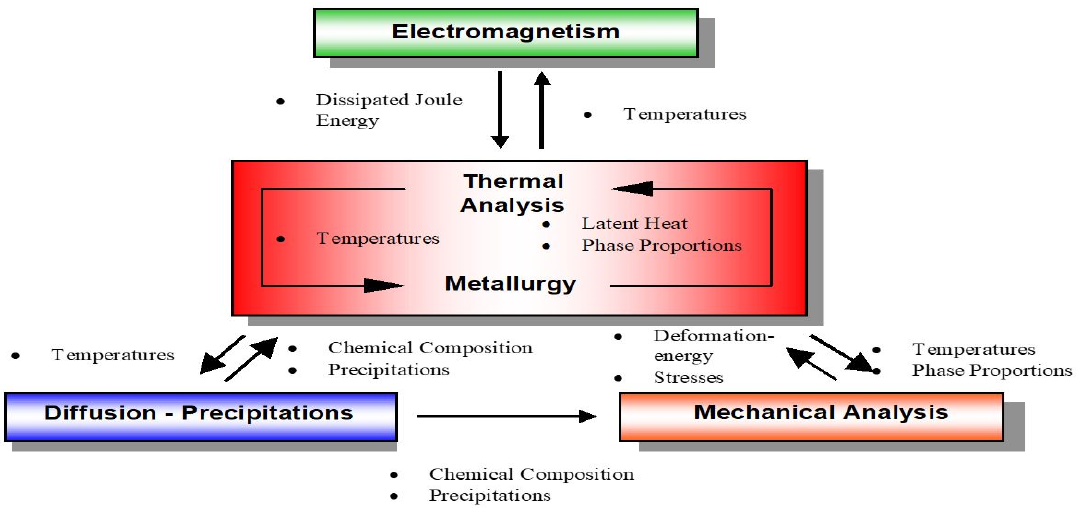
Figure 1. The SYSWELD solver architecture [39].